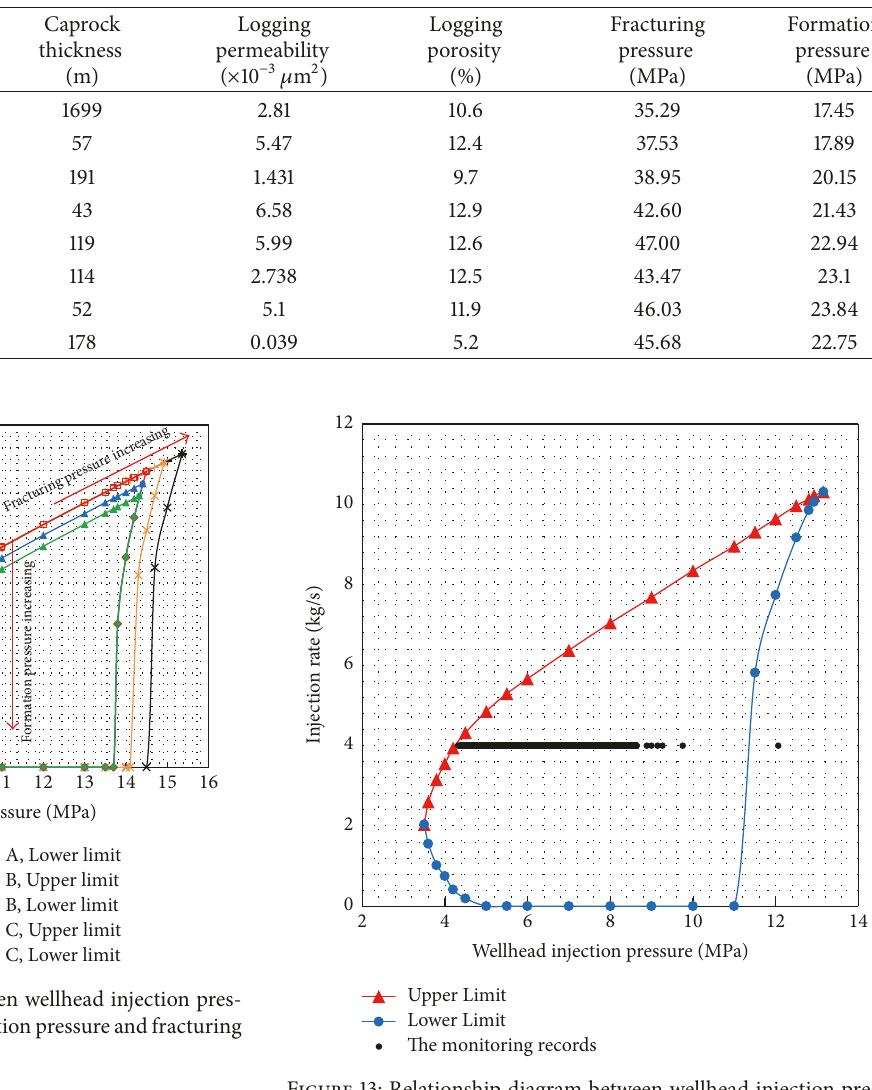
Figure 13: Relationship diagram between wellhead injection pres- sure and injection rate in Shenhua CCS